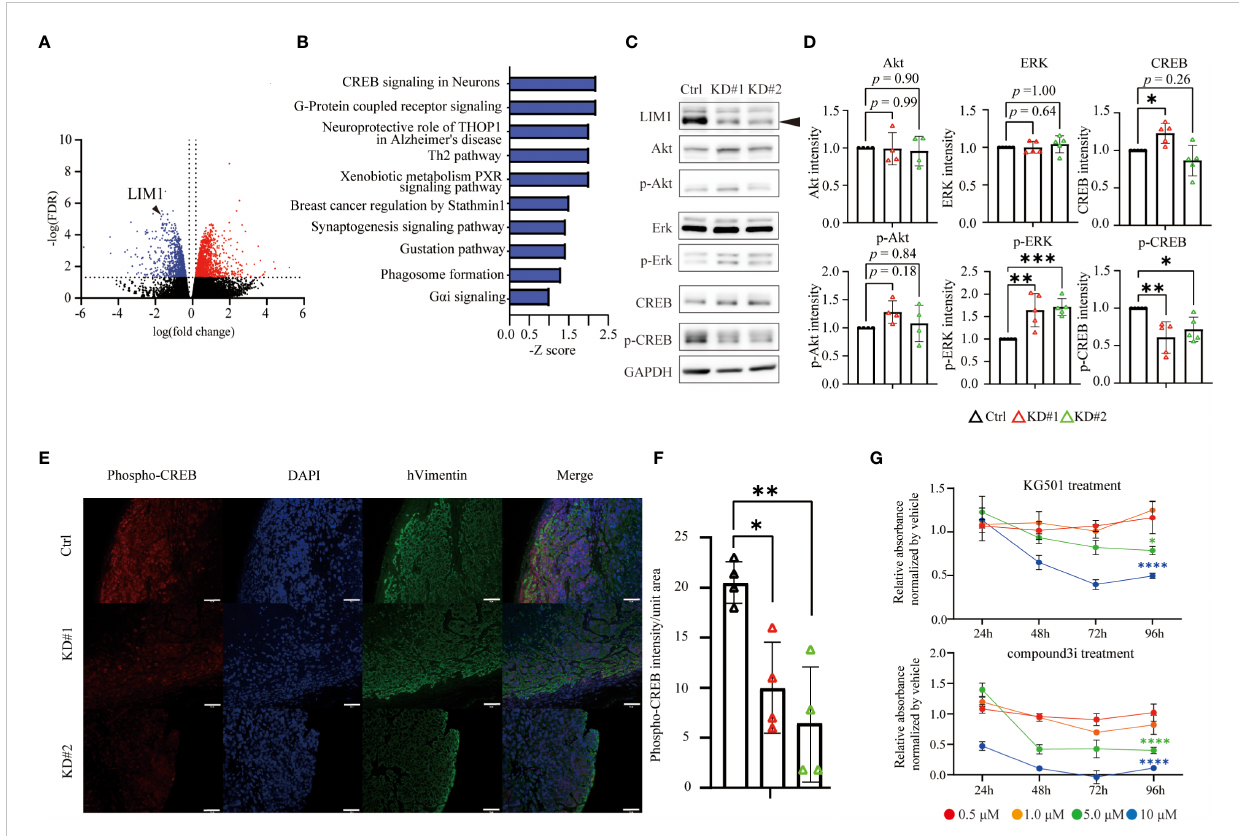
FIGURE 5 LIM1 promoted CREB phosphorylation in EC. (A) Volcano plot of DEGs in LIM1-KD (#1 and #2) cells versus Ctrl cells generated from RNA-seq results. (B) The highly ranked GO cluster among commonly downregulated genes in LIM1-KD cells compared with Ctrl cells by Ingenuity Pathway Analysis (IPA). (C) Western blotting of LIM1, ERK, phospho-ERK, CREB, phospho-CREB, and GAPDH using Ctrl cells and LIM1-KD cells. (D) Relative intensities of Akt, phospho-Akt, ERK, phospho-ERK, CREB, phospho-CREB bands by western blot analysis. Signals intensities were normalized to the GAPDH intensity in the same samples and then the intensity of the LIM1-KD (#1 and #2) cells were normalized to Ctrl cells [n = 5 (ERK, p-ERK, CREB, p-ERK), n = 4 (Akt, p-Akt) one-way ANOVA]. (E) Immuno fl uorescent staining for phospho-CREB and human vimentin in sections of xenograft tumors derived from Ctrl cells and LIM1-KD cells. Red: phosphorylated CREB, blue: nucleus, green: human vimentin. (F) Intensity of phospho-CREB in the tumor region (n = 4, one-way ANOVA). * p < 0.05, ** p < 0.01. Graphs show means ± standard deviations. (G) MTT assay to assess cell proliferation. HEC50B cells were treated with CREB inhibitors, KG501 and compoun3i, respectively. Red, orange, green and blue indicate inhibitor concentrations at 0.5 m M, 1.0 m M, 5.0 m M and 10 m M, respectively. (n = 5, two-way ANOVA * p < 0.05, ** p < 0.01, *** p < 0.001, **** p <